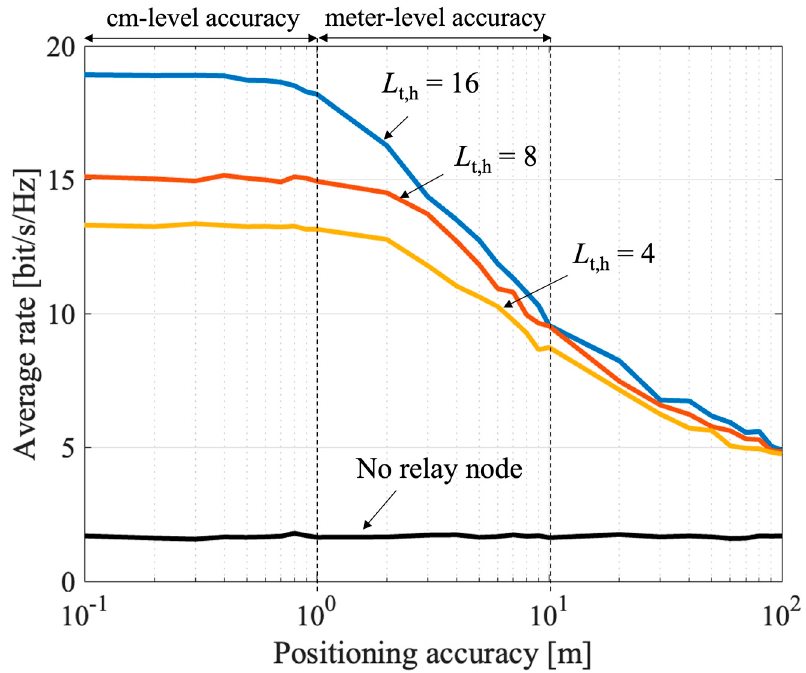
Figure 9. Impact of location estimation error on the UE with high-precision